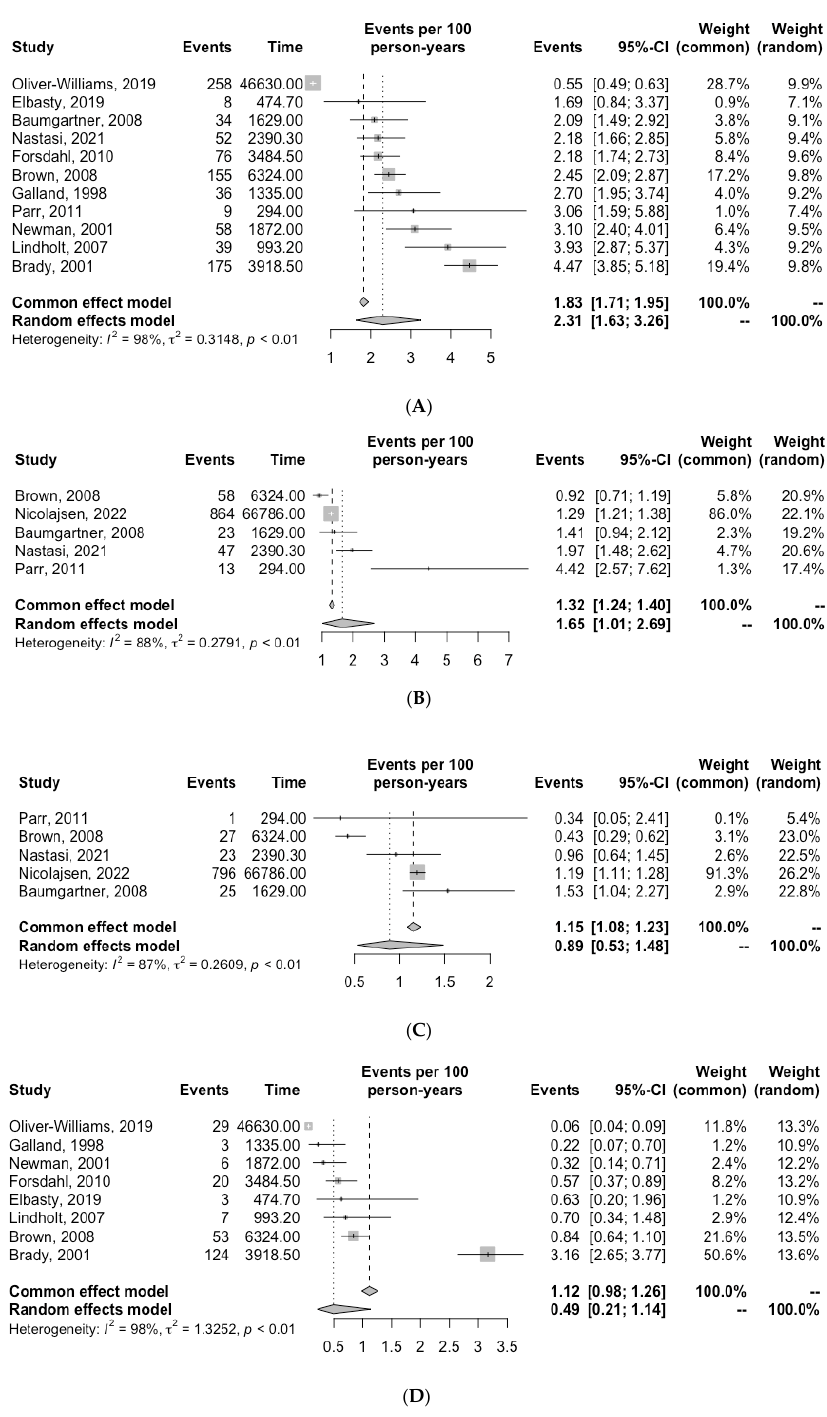
Figure 2. Incidence of ( A ) cardiovascular death, ( B ) myocardial infarction ( C ) stroke and ( D ) AAA- related death for patients with unrepaired AAA. Grey squares indicate the incidence of events per 100 person-years (PY) and horizontal lines indicate the 95% CI for each study. The diamond repre- sents the respective incidence for patients with unrepaired AAA calculated with random-effects meta-analysis [6,7,10–16,20,21].